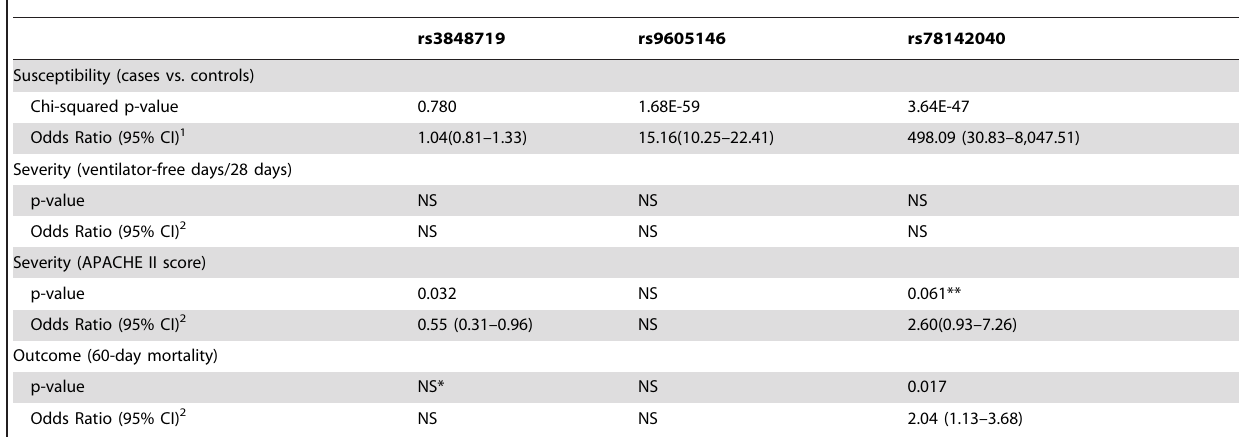
Table 5. Overall association